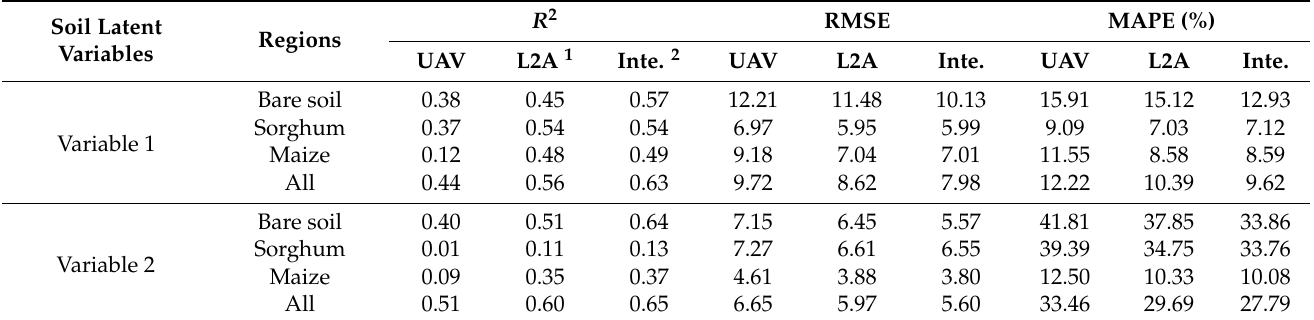
Table 4. Estimation accuracy assessment of soil latent variables using different remote sensing indicators.